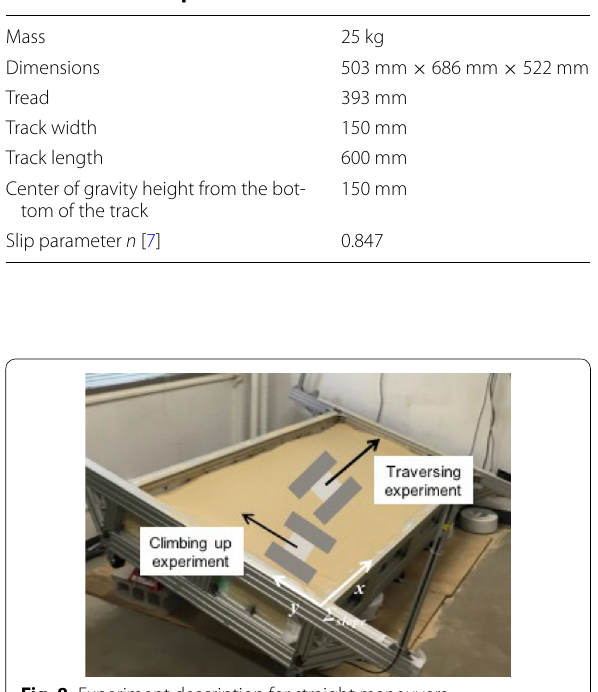
Fig. 8 Experiment description for straight